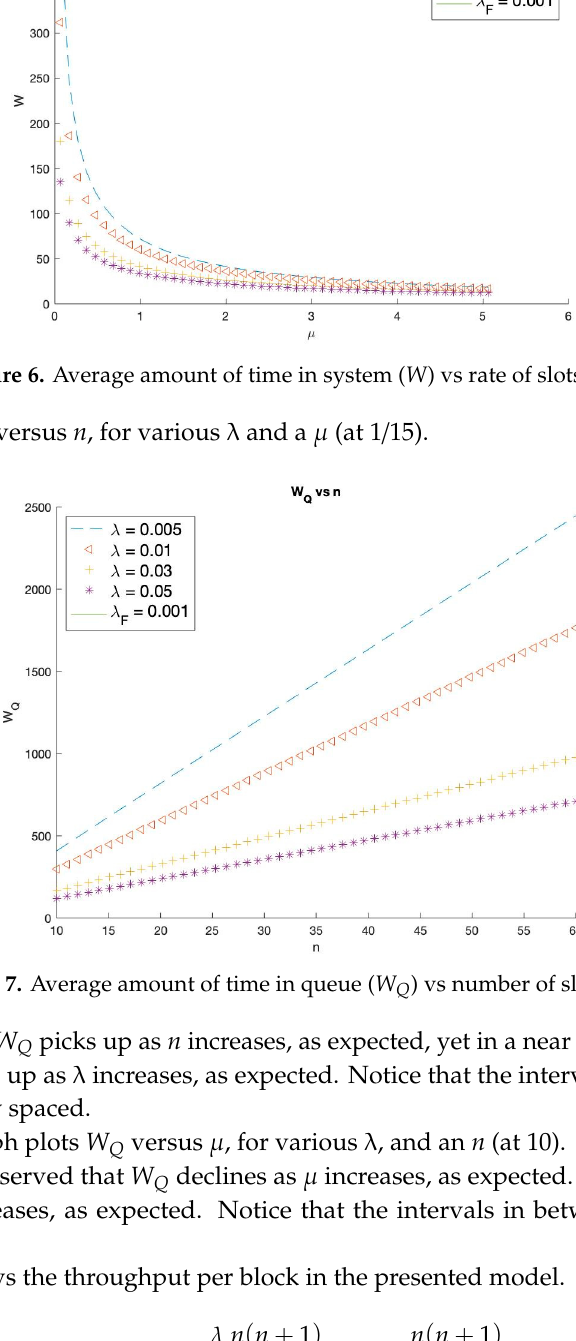
Figure 8. Average amount of time in queue ( (cid:1849) (cid:3018) ) vs rate of slots ( (cid:2020) ). Equation (10) shows the throughput per block in the presented model. (cid:2011) = (cid:2020)(cid:1842) (cid:3041) = (cid:2020) (cid:2019) (cid:2020) (cid:1866)((cid:1866) + 1) 2